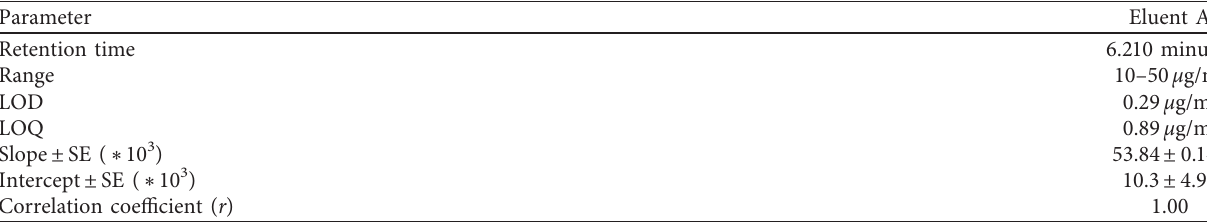
Table 2: Regression analysis data for levamisole.